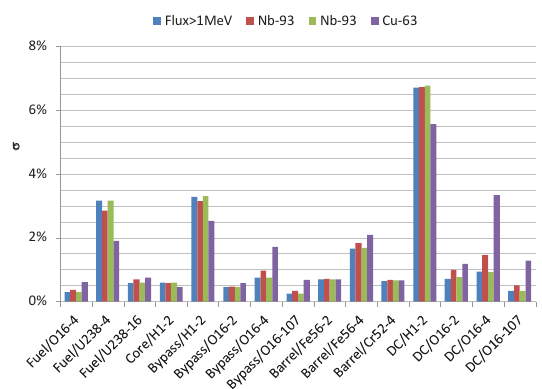
Figure 2. Simplified illustration on the Swiss BWR validation case.